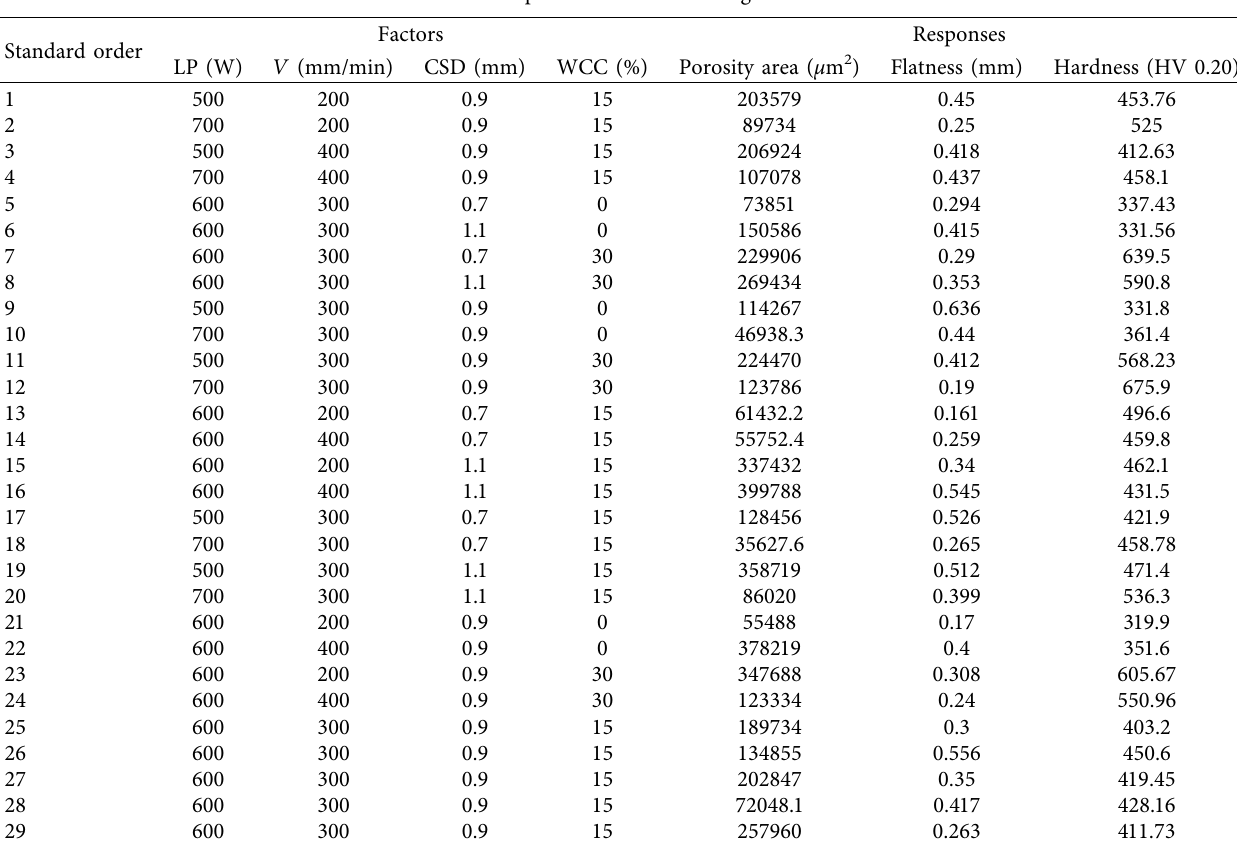
Table 4: BBD experimental scheme design and